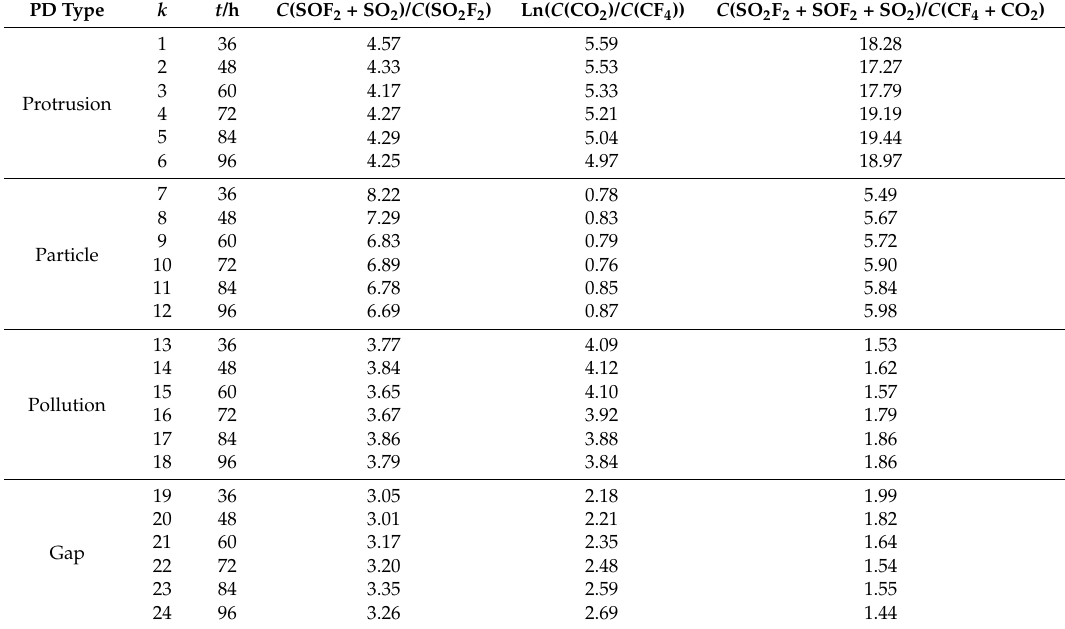
Table 4. Input matrix of BP neural network.